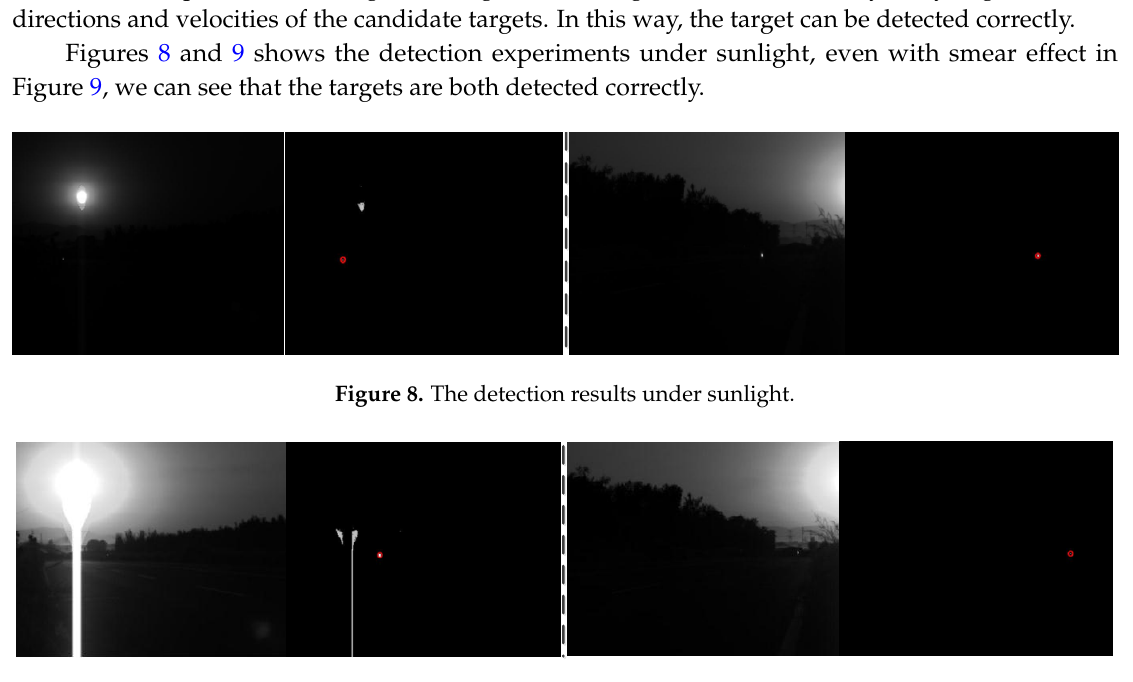
Figure 9. The detection results under sunlight with smear